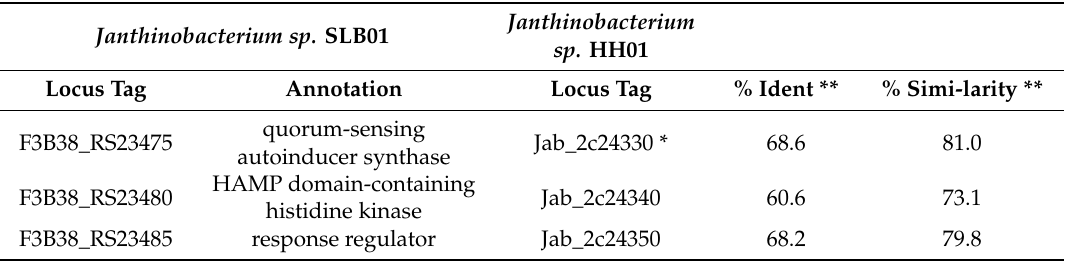
Table 2. Quorum sensing gene description in the Janthinobacterium sp. SLB01 genome.